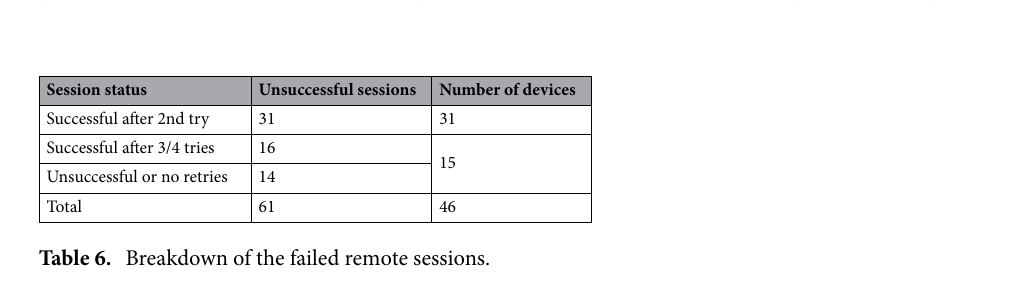
Table 5. Preliminary data from Limited Market Release of the remote care platform.